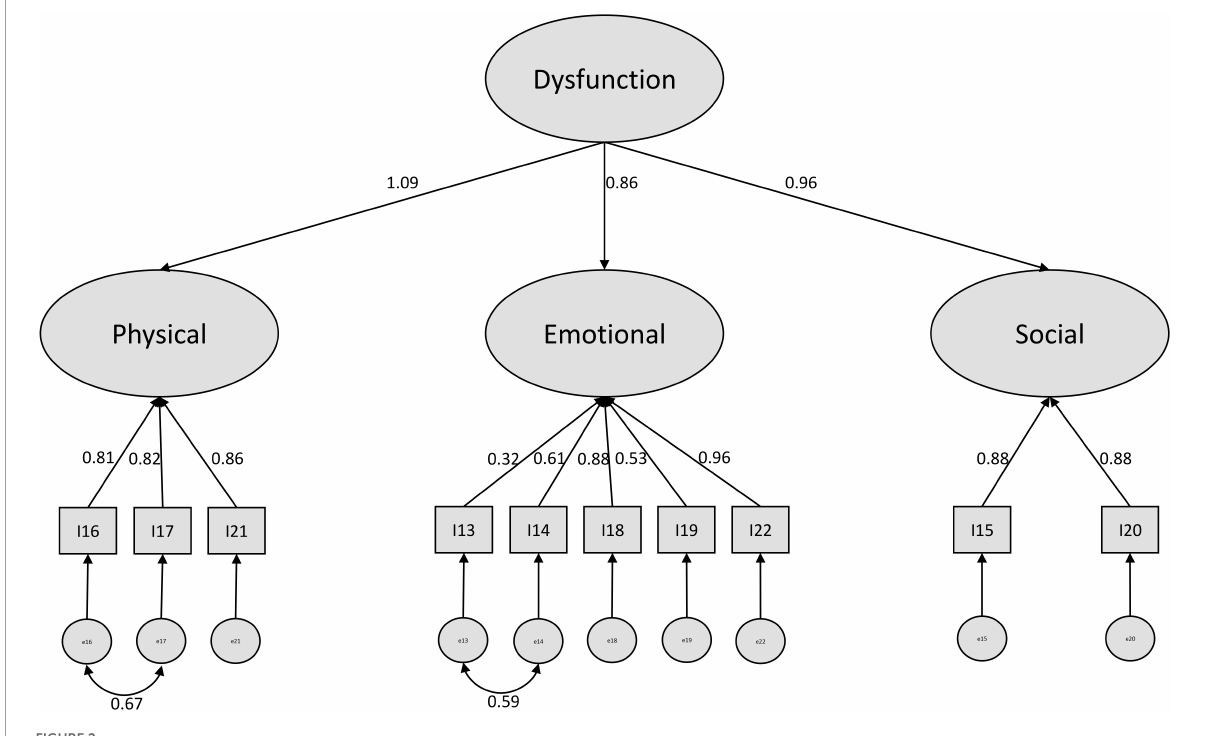
FIGURE2 Modified higher order CFA model with standardized estimates (positive subscale).